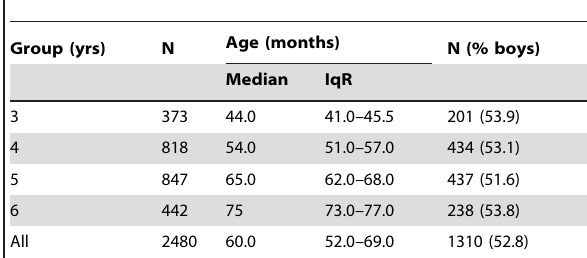
Table 1. Age and Gender of the Participants.